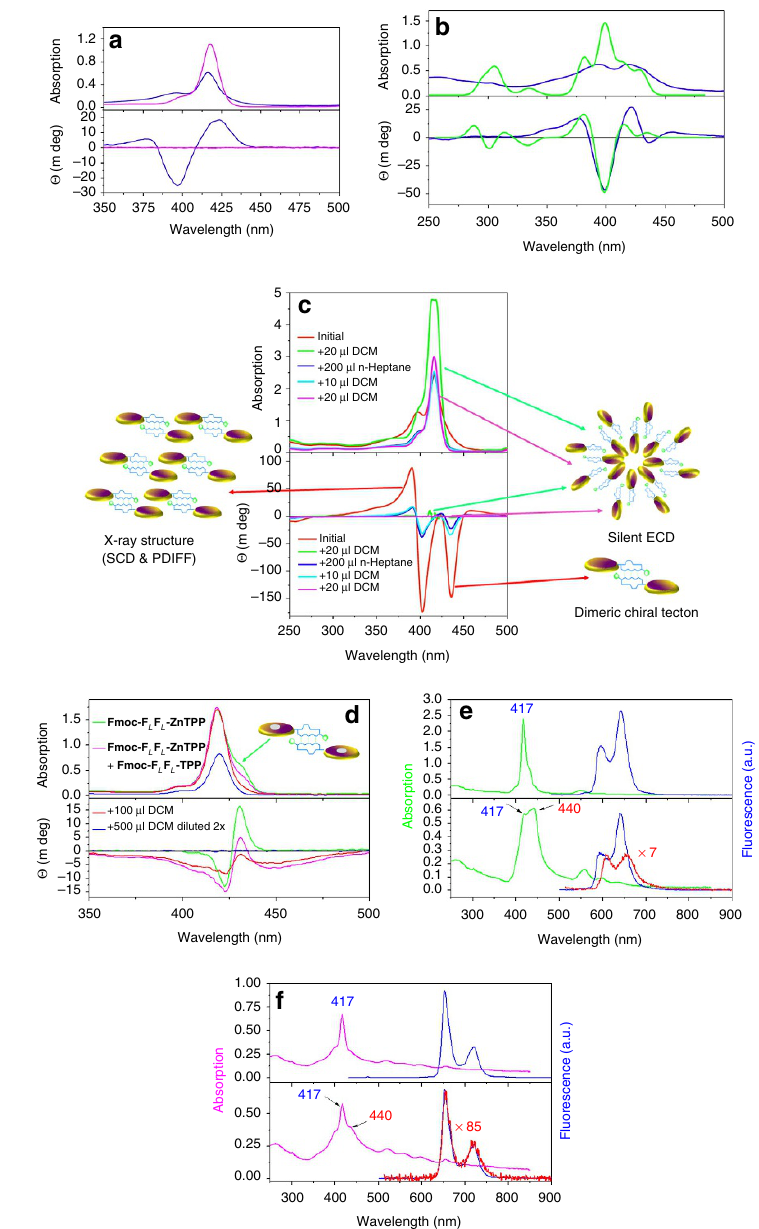
Figure 4 | Ultraviolet-Vis absorption with ECD and fluorescence spectra of X-F L F L -TPP. ( a ) Fmoc-F L F L - TPP dissolved in dichloromethane (magenta traces with silent ECD spectrum in the Soret region) and after injection into n -heptane (blue traces). ( b ) Experimental (blue traces) versus calculated spectra (green traces) for self-assembled Fmoc-F L F L - TPP in n -heptane. An arbitrary scaling was performed at the maximum of the largest negative Cotton effect. ( c ) Boc-F L F L - TPP on changing the solvent composition as indicated in the inset. Half of the solution volume was removed from the cuvette and the corresponding amount of n -heptane was added. The Soret band of the green trace after addition of the first aliquot of 20 m l dichloromethane is slightly truncated due to saturation of the detector. The cartoons symbolize different self-assemblies of TPP (discs) via triple hydrogen bonding of the FF- dipeptide moieties (blue forms) protected by Fmoc or Boc groups (green spheres). ( d ) Fmoc-F L F L - ZnTPP after injection in n -heptane (green trace). In the chiral dimer, we presumed that due to the Fmoc protecting group there is no coordination to the Zn atom (grey disk). The magenta trace was obtained from Fmoc-F L F L - ZnTPP (1.85mg dissolved in 400 m l dry dichloromethane) admixed (4/1, v/v) with Fmoc-F L F L - TPP (2.57mg dissolved in 500 m l dry dichloromethane). A volume of 1.5 m l of this mixture was injected into n -heptane. Dilution with aliquots of dry dichloromethane gradually leads to a silent ECD (blue trace, after a twofold dilution). ( e ) Absorption of Fmoc-F L F L - ZnTPP after injection in n -heptane (green trace, lower panel) and after addition of dichloromethane (upper panel). The corresponding fluorescence spectra were obtained after excitation at 417nm (blue traces) or at 440nm (red trace). ( f ) Absorption of Fmoc-F L F L - TPP after injection in n -heptane (magenta trace, lower panel) and after addition of dichloromethane (upper panel). The corresponding fluorescence spectra were obtained after excitation at 417nm (blue traces) or at 440nm (red trace). The red fluorescence traces were vertically scaled by multiplying with factors of 7 and 85, which reflect the amount of quenching in the nonpolar solvent.